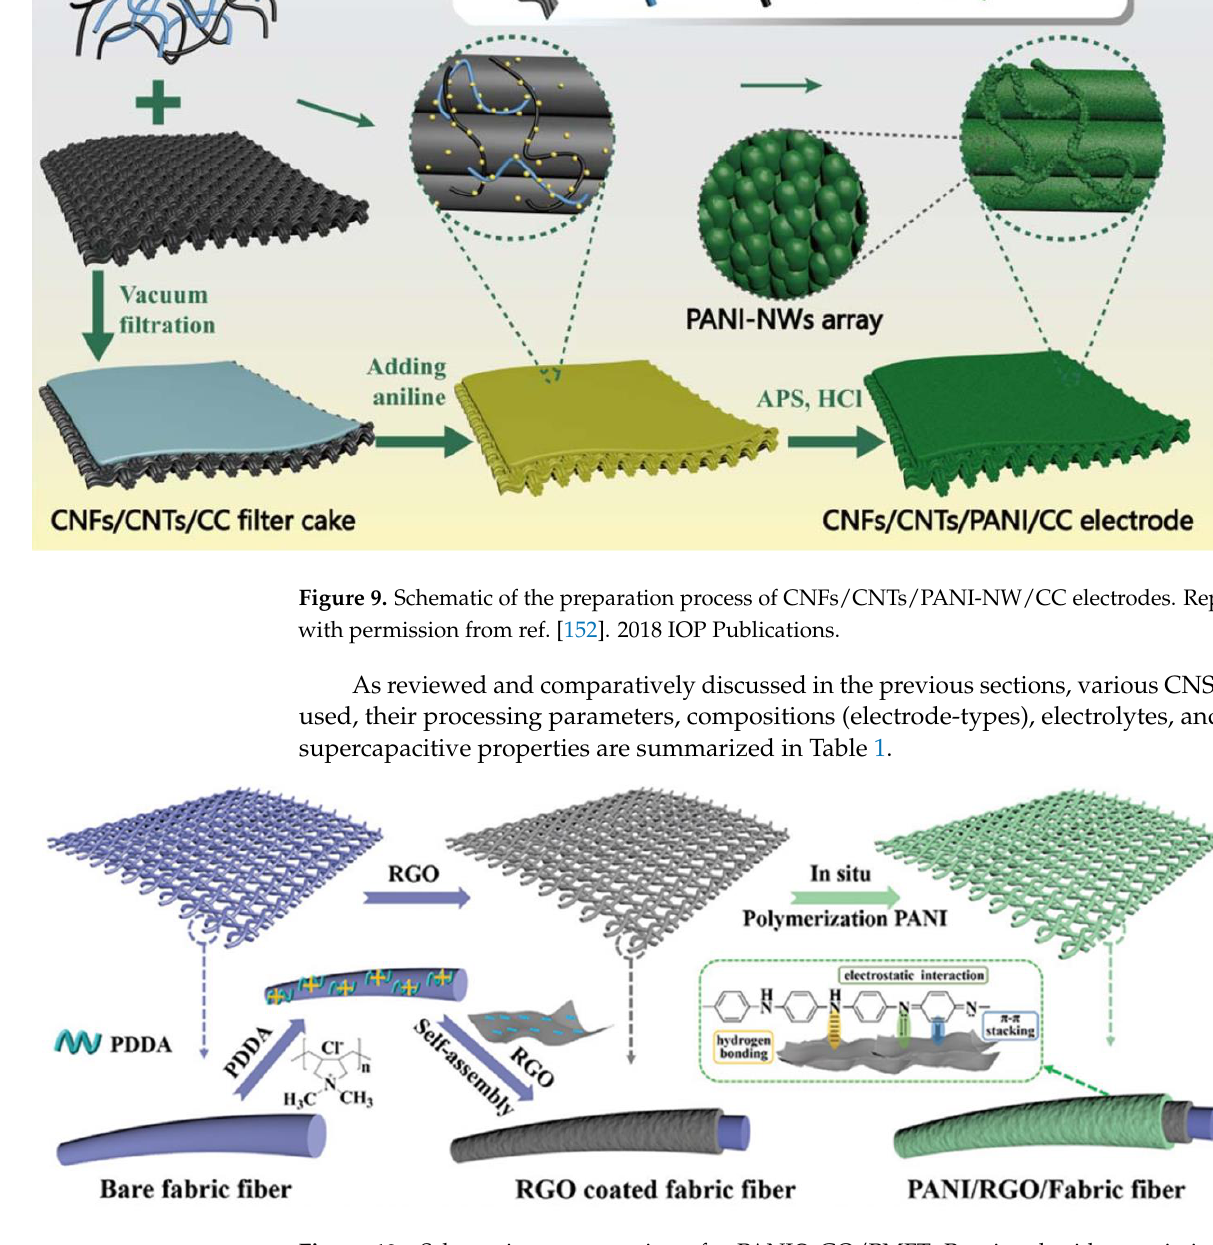
Table 1. Cellulose-derived nanostructure-based supercapacitors.